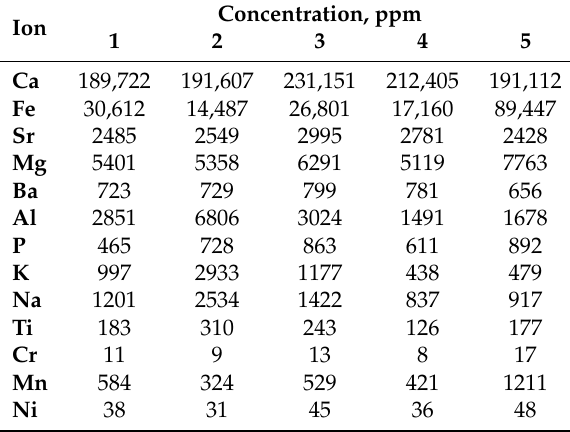
Table 3. The concentration of metallic ions extracted from solid scale samples by ICP-MS analysis.